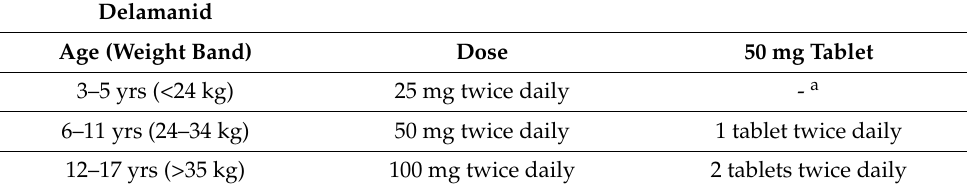
Table 9. Delamanid recommended